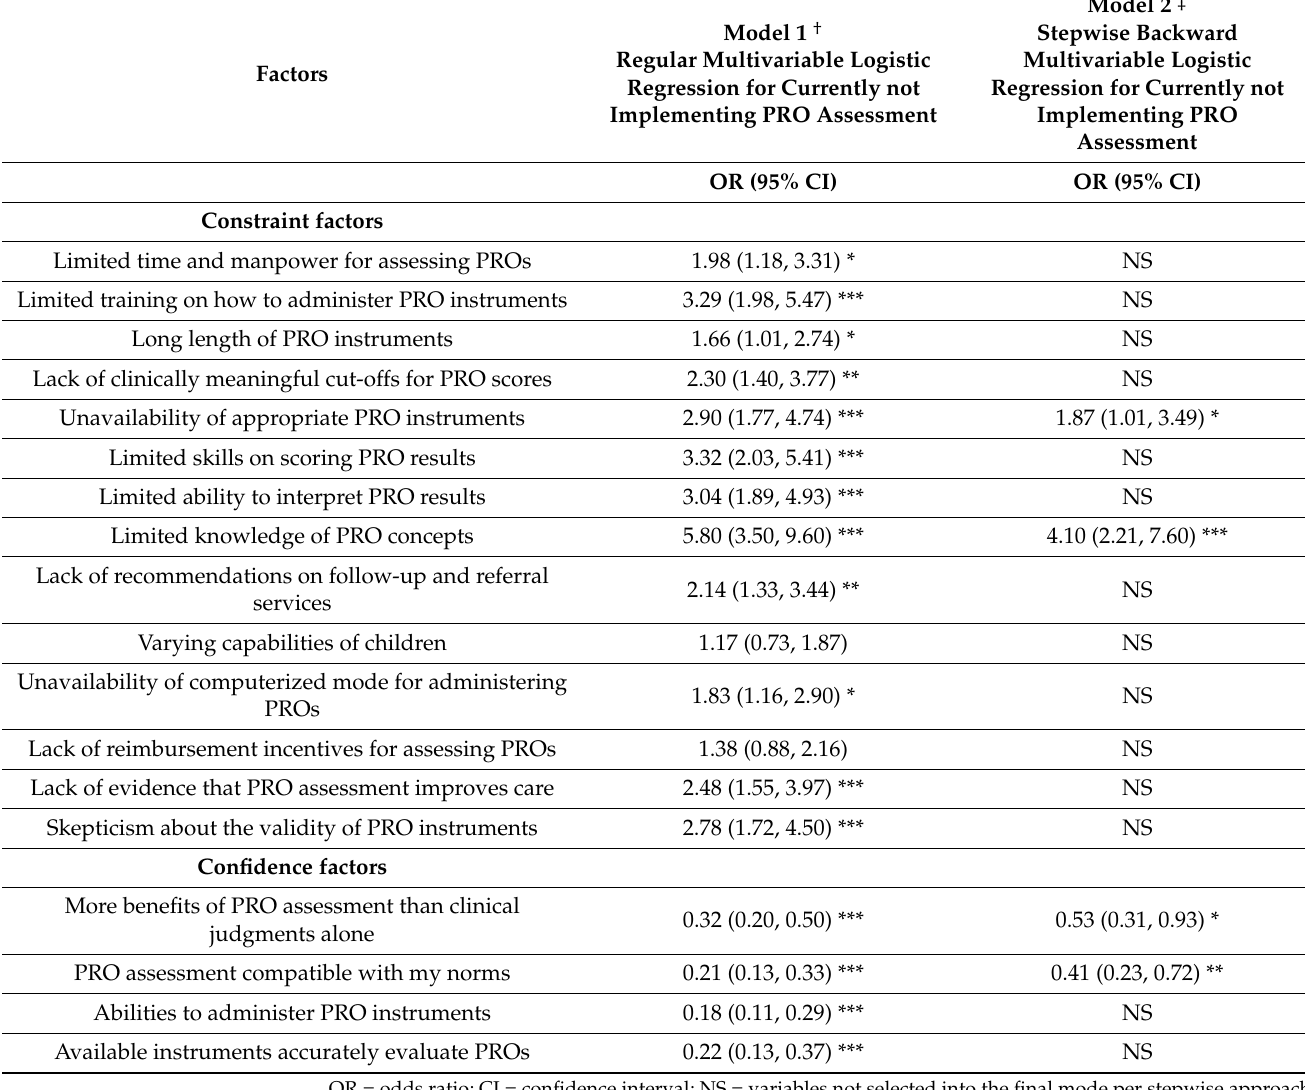
Table 4. Multivariable Analyses for the Barrier and Confidence Factors Associated with Currently Not Implementing PRO Assessment in Clinical Practice &